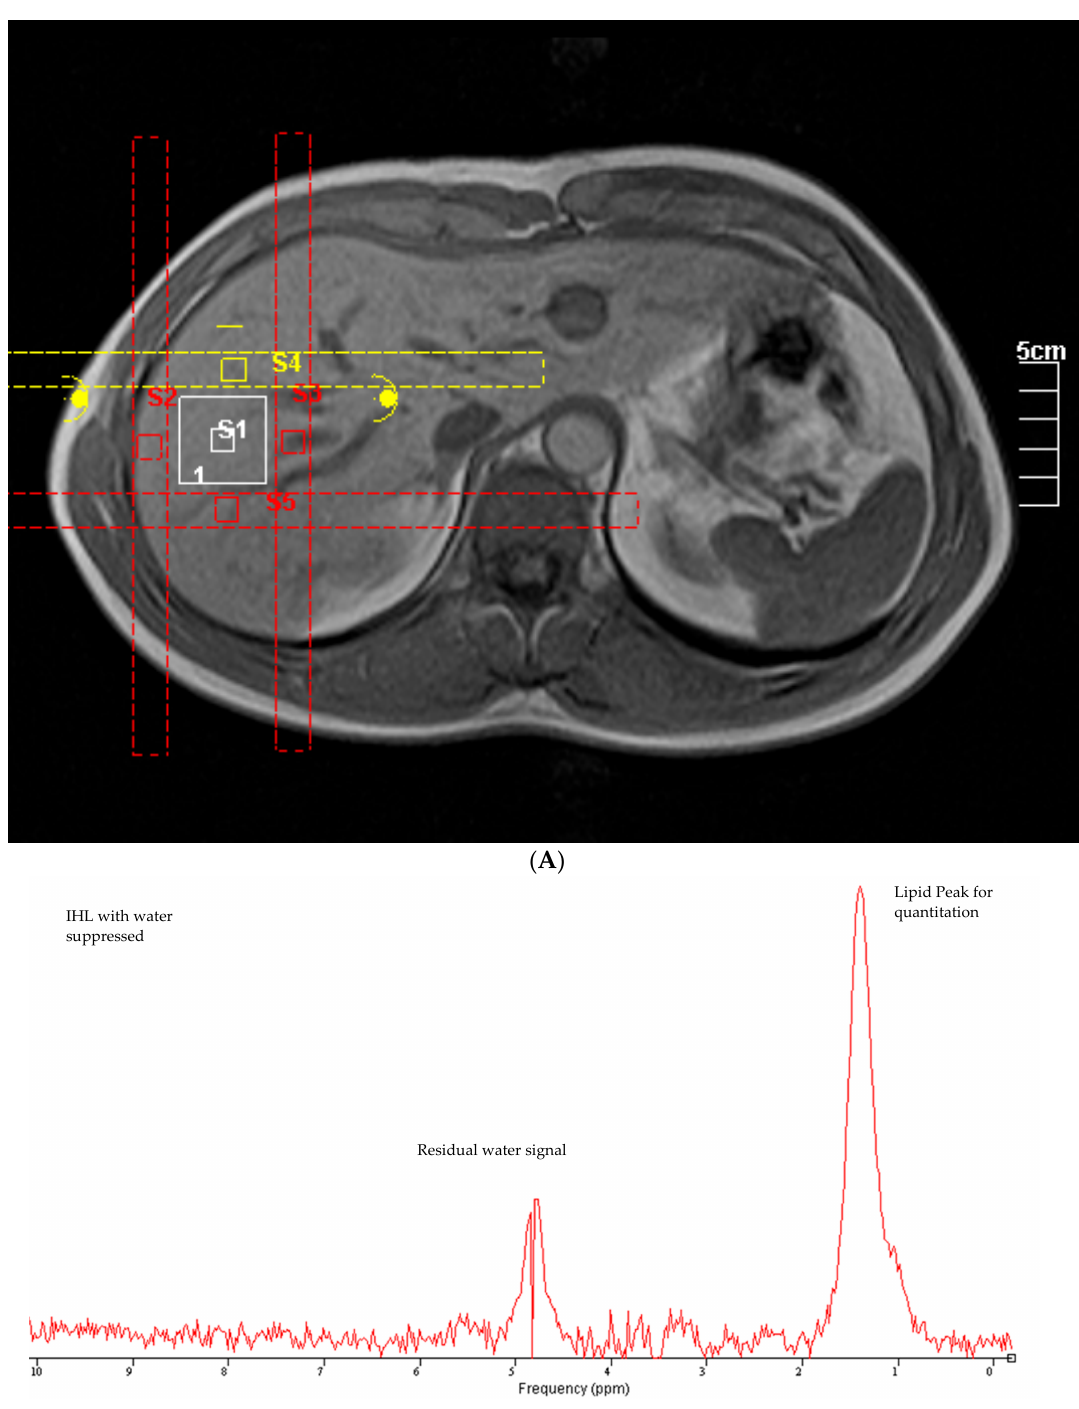
Figure 2. ( A ) MRI of liver detailing the location of voxel and ( B ) an example of 1-H spectroscopy derived measurement of intrahepatic lipid.